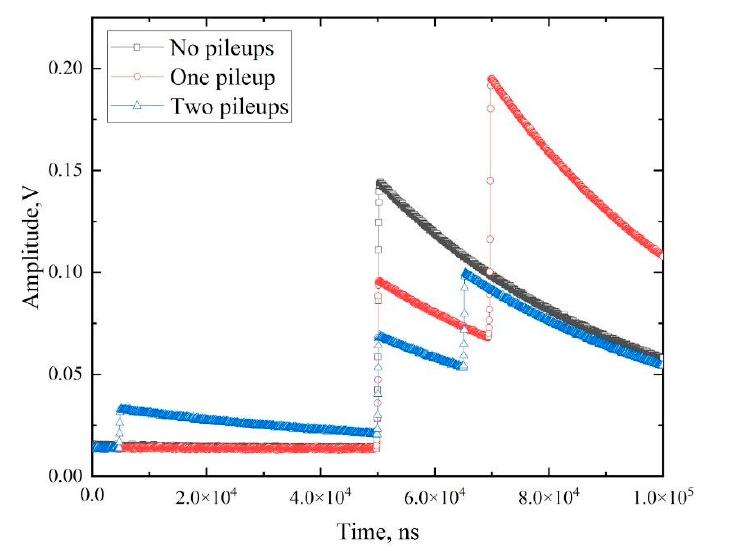
Figure 1. Signal waveforms from the HPGe detector of Doppler broadening spectrometer with different numbers of signal pileups.